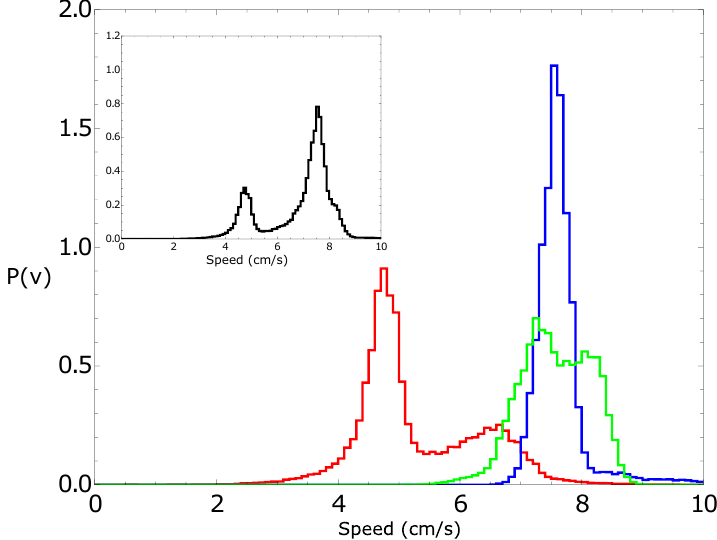
Figure 13. The probability distribution of the speeds. The large figure shows the results of individual experiments. The distribution of the speed values observed in all experiments is shown in the